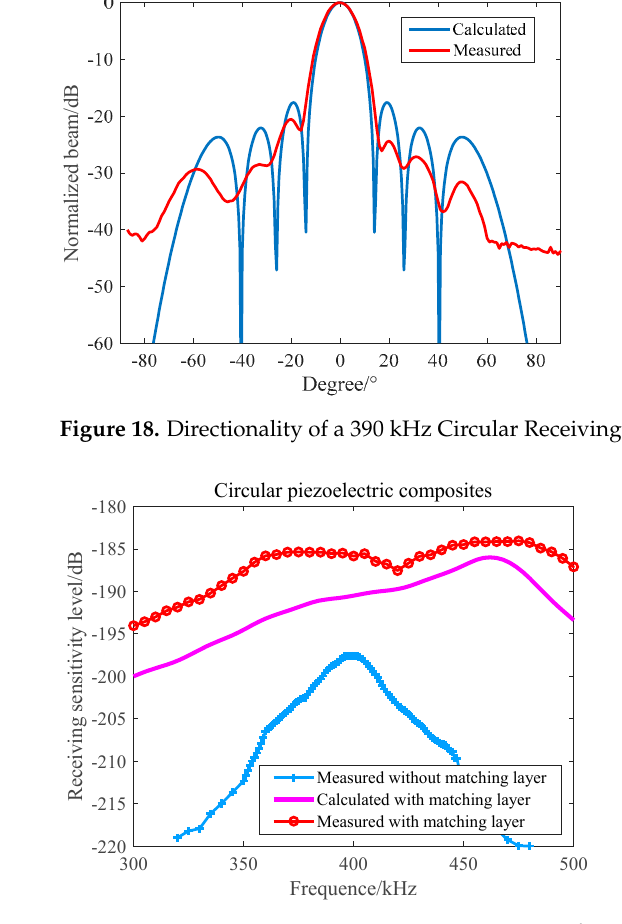
Figure 19. Receiving Sensitivity–Frequency Curve of a Circular Receiving Array.